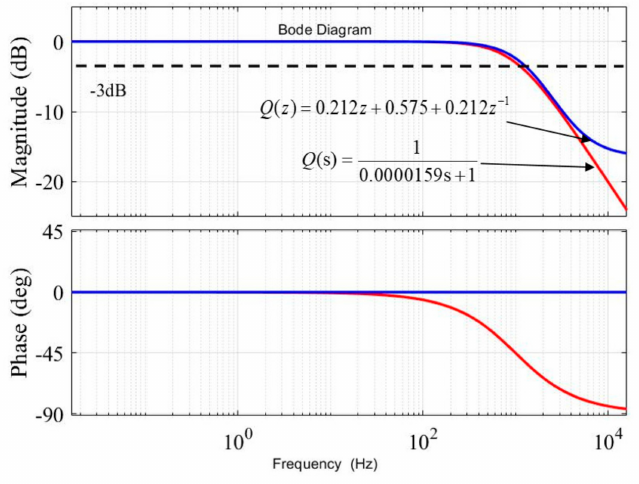
Figure 9. Bode plot of Q ( z ) with different filters.